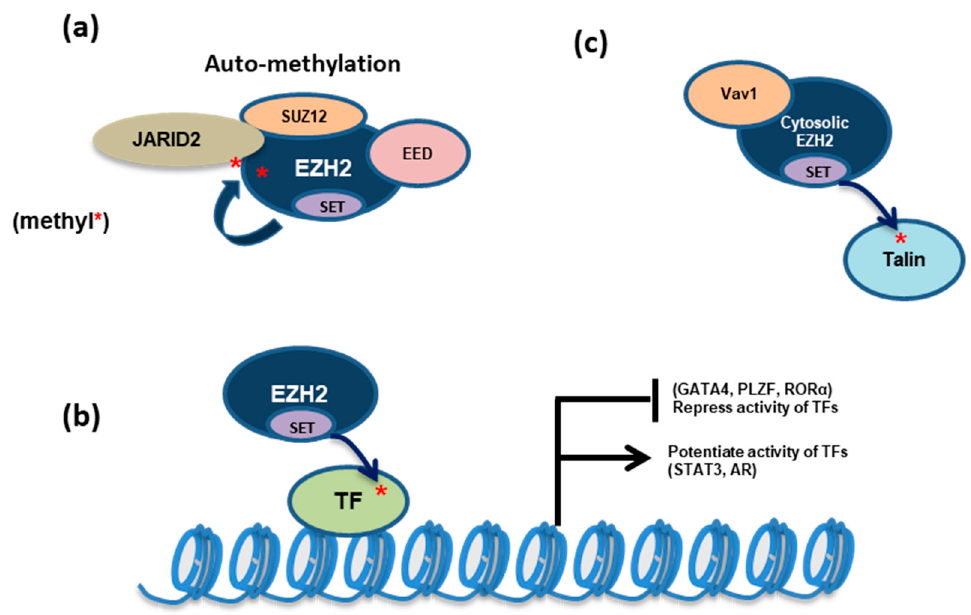
Figure 2. Besides inducing H3K27me3, EZH2 also methylates nonhistone proteins, either in the PRC2-dependent or PRC2-independent manner. ( a ) PRC2:EZH2 methylates EZH2 (automethylation) or JARID2, a PRC2 accessory cofactor, for enhancing PRC2:EZH2’s methyltransferase activity. ( b ) EZH2 can methylate a number of transcription factors (TFs) to either activate or repress their transcription-regulatory function. ( c ) In the cytosol, EZH2 interacts with Vav1 and methylates talin, thereby regulating cell adhesion and mobility. *, EZH2-methylated lysine site.